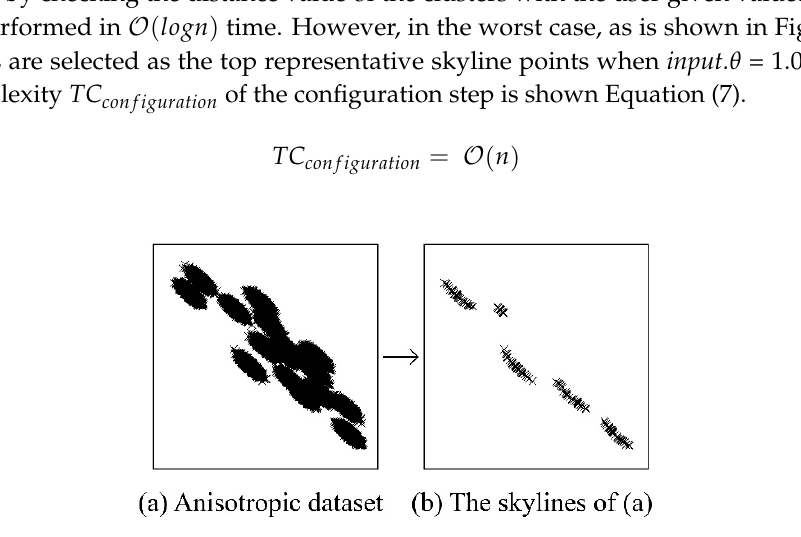
Figure 8. Visualization of the Anisotropic dataset.